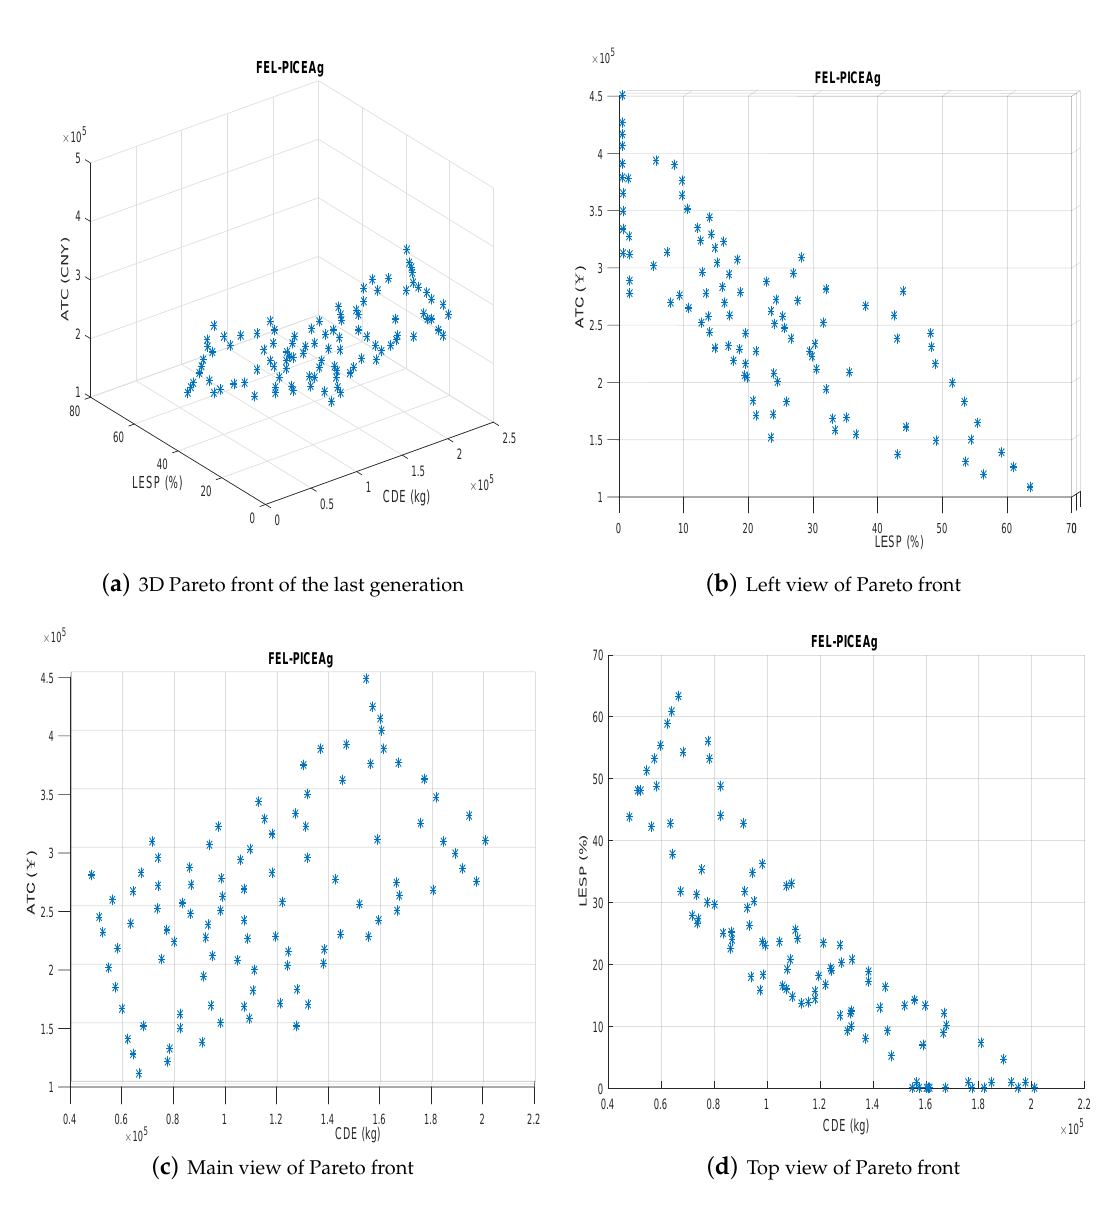
Figure 10. RECCHP in FEL. ATC: annual total cost; CDE: carbon dioxide emission; LESP: loss of energy supply